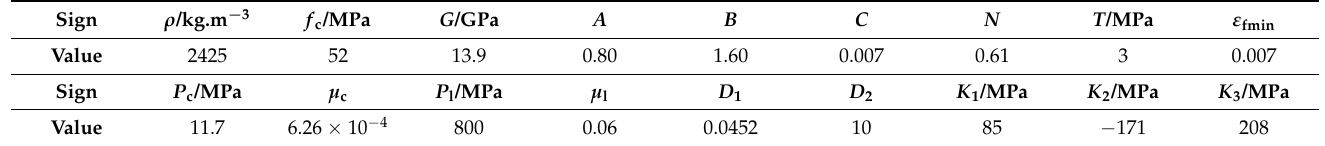
Figure 1. Schematic diagram of Brazilian cleavage (The numbers in the figure indicate the monitoring points). Table 1. Material parameters of JHC